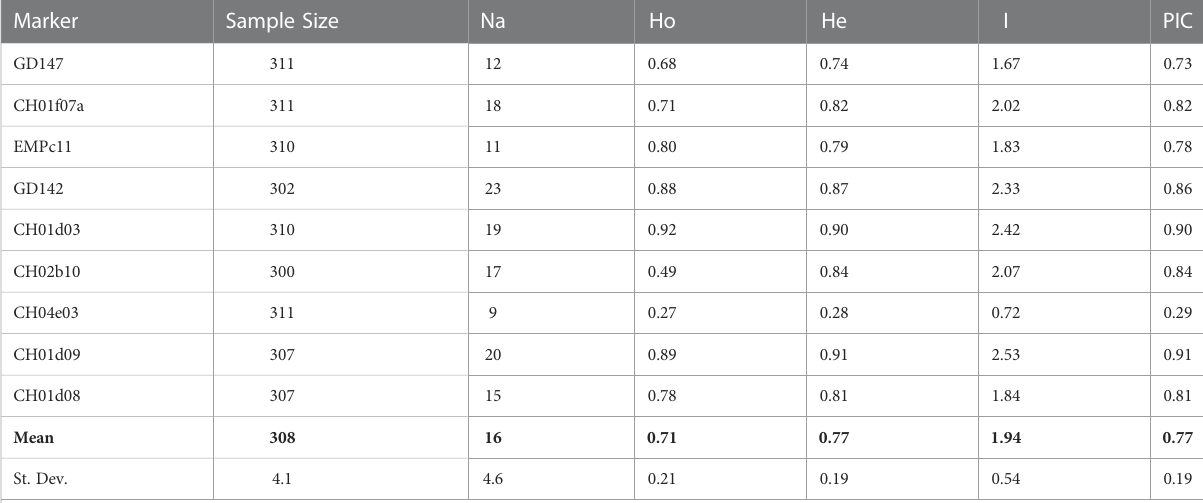
TABLE 2 SSR descriptive statistics reporting the sample size and the number of observed alleles (Na) of all 311 individuals successfully ampli fi ed for each locus.